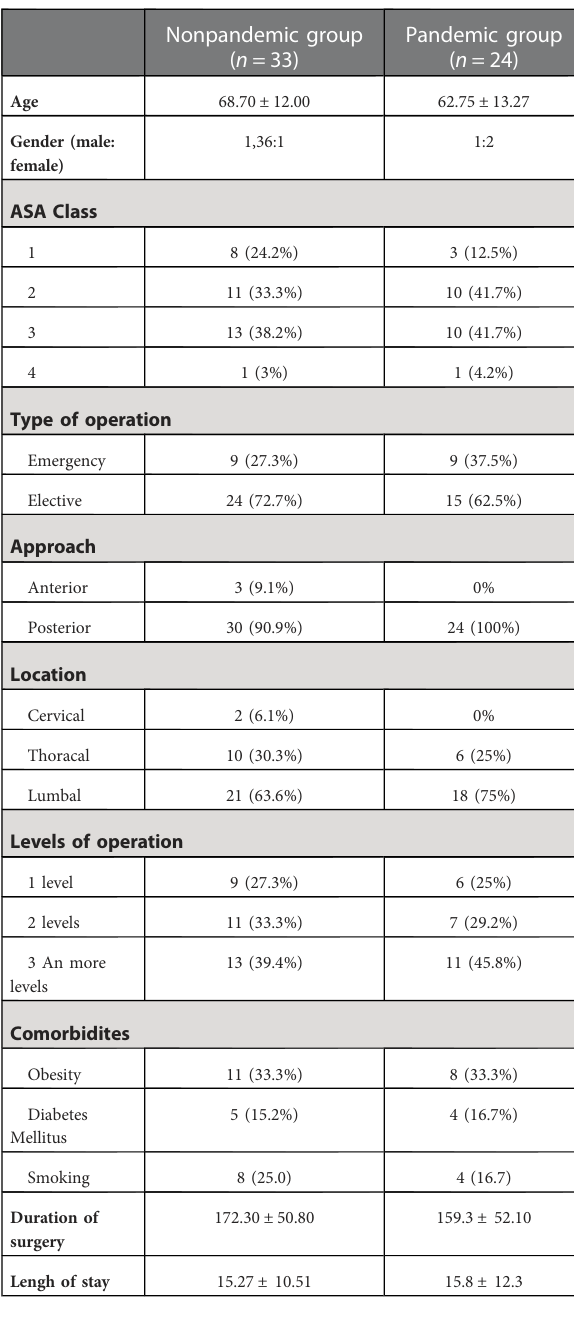
TABLE 2 Patients with